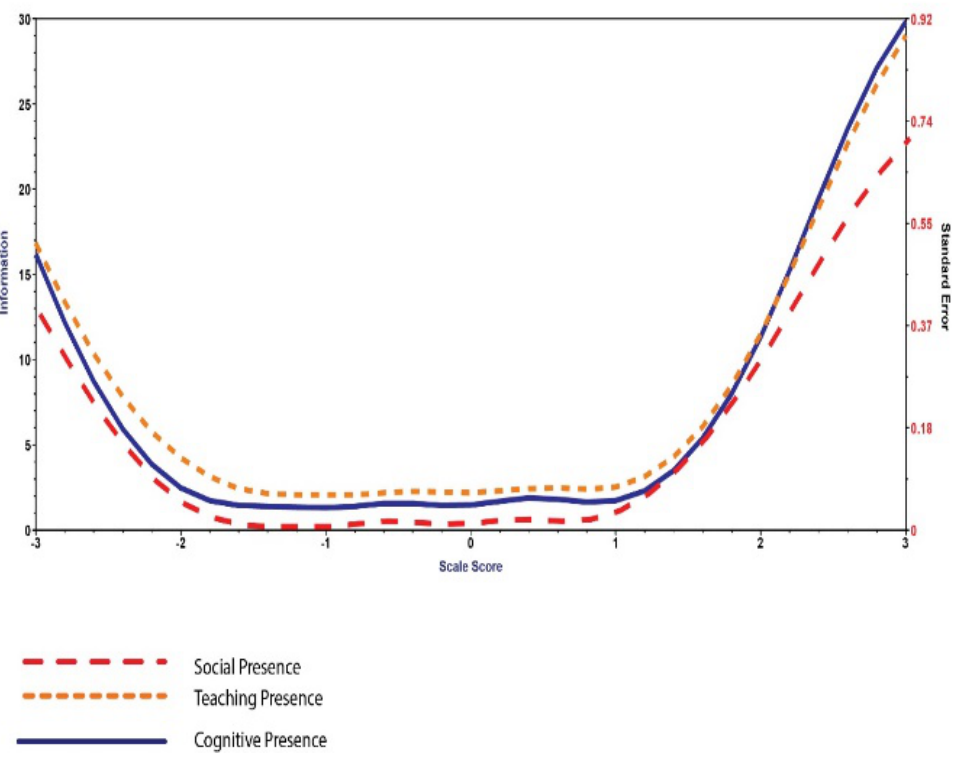
Figure 3 . Standard Error Function for each of the three